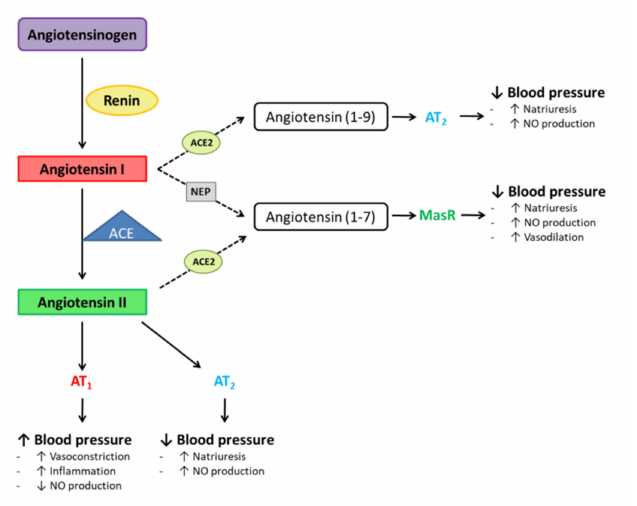
Figure 2. Schematic representation of the renin–angiotensin system. ACE: angiotensin-converting enzyme, ACE2: angiotensin-converting enzyme 2, AT 1 : angiotensin receptor 1, AT 2 : angiotensin receptor 2, MasR: Mas receptor, NEP: neprilysin, NO: nitric